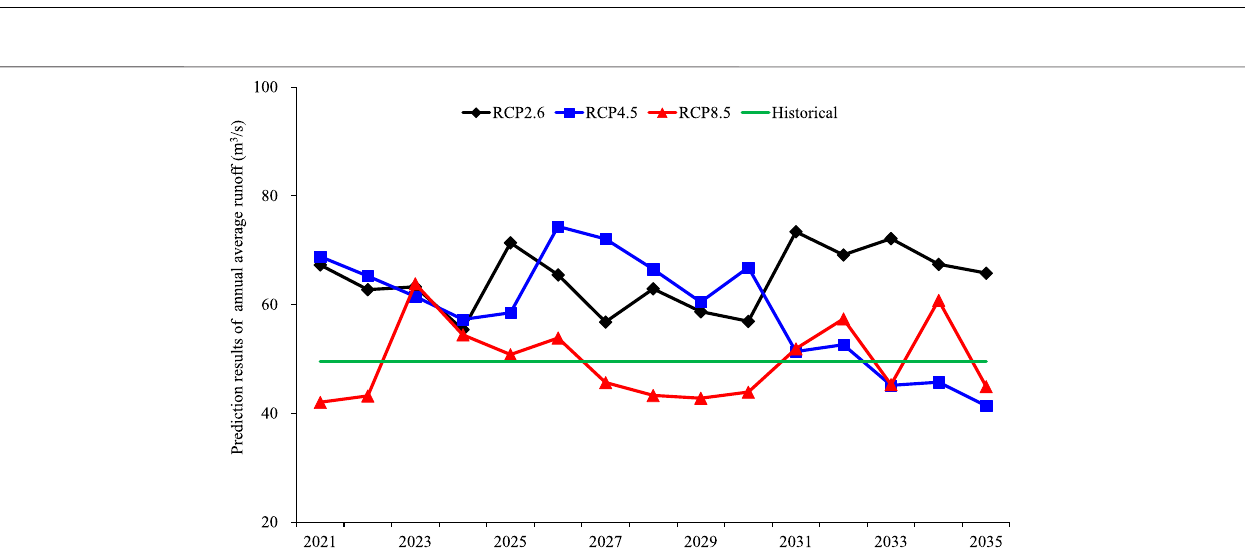
FIGURE 11 | The predicted runoff data at the exit of the basin under different representative concentration pathways (RCPs).